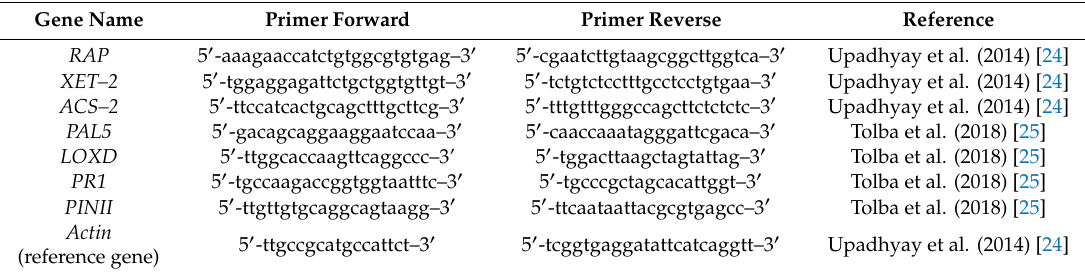
Table 2. Oligonucleotides with sequences used for quantitative real time polymerase chain reaction